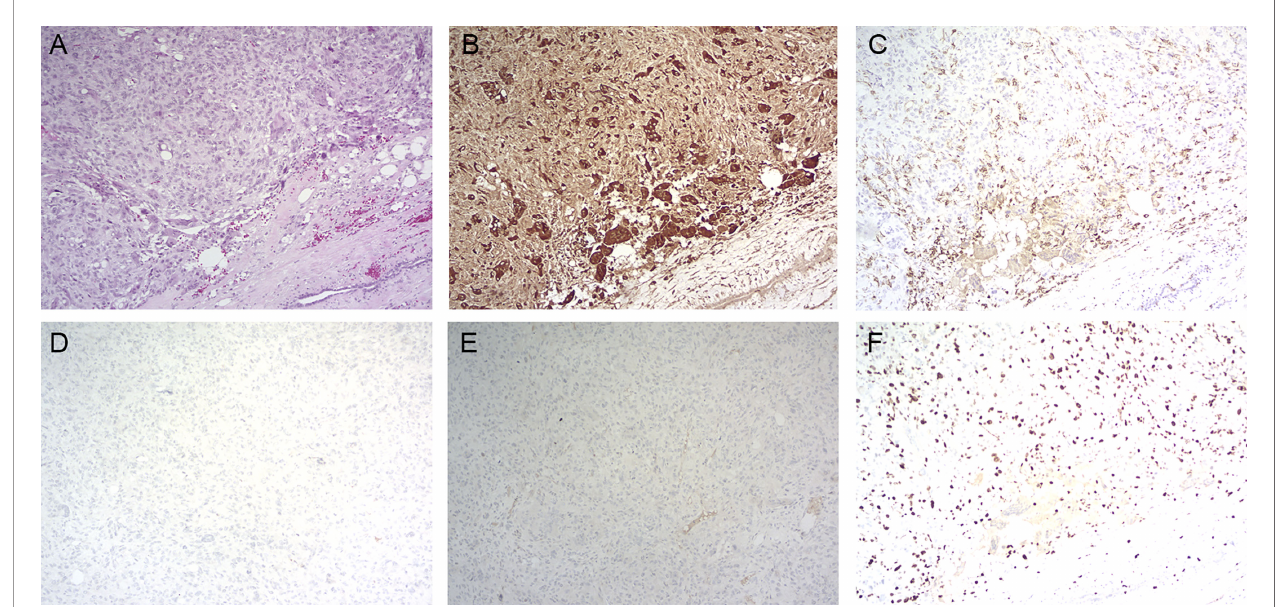
FIGURE 3 | Histopathology of primary tumor. (A) Hematoxylin and eosin staining (magni fi cation: ×100); (B) immunohistochemistry for CD68 (magni fi cation: ×100); (C) immunohistochemistry for CD163 (magni fi cation: ×100); (D) immunohistochemistry for PR (magni fi cation: ×100); (E) immunohistochemistry for ER (magni fi cation: